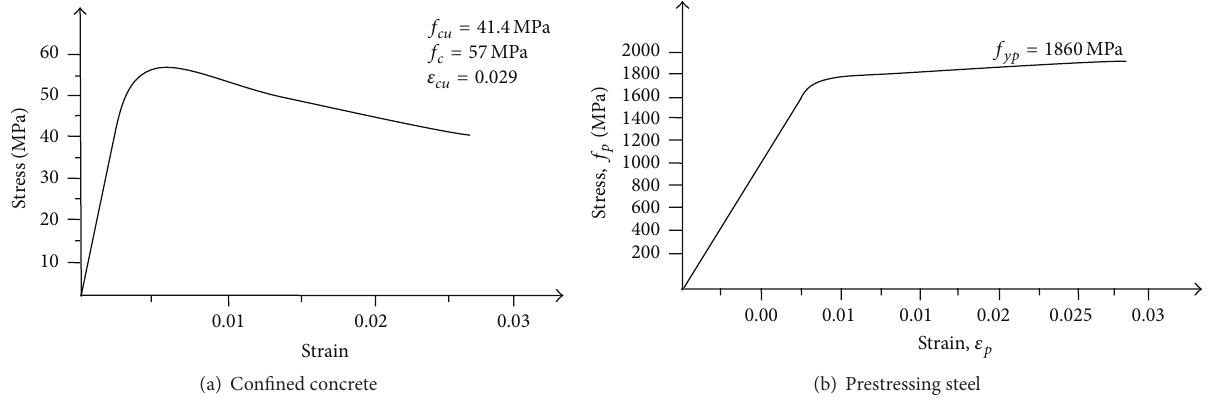
Figure 2: Stress-strain curves for materials [4, 22].